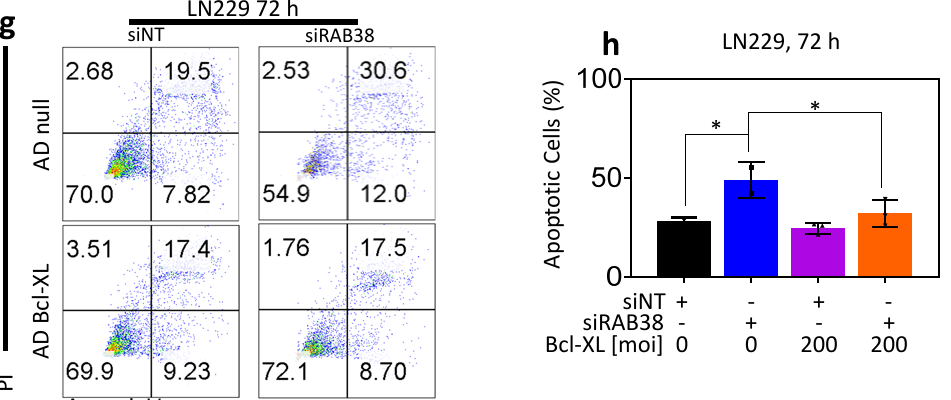
Figure 4. RAB38 silencing downregulates the protein expression of antiapoptotic Bcl-2 family members. ( a – c ) RAB38 knockdown was performed in LN229 ( a ), T98G ( b ), and GBM43 ( c ), and whole-cell protein extracts were examined by Western blot analysis of Mcl-1, Bcl-2, Bcl-xL, and RAB38. β -Actin Western blot analysis was performed to confirm equal protein loading. Protein quantification was analyzed through ImageJ. Representative plots and a histogram with statistical analysis are presented ( n = 3). ( d ) Bcl-xL overexpression was performed in LN229 using an adenovirus, and whole-cell protein extracts were examined by Western blot analysis of Bcl-Xl and β -actin. Bar graphs display protein quantification levels determined by ImageJ. ( e , f ) LN229 cells were transfected with nontargeting (NT) or RAB38-specific siRNA (siRAB38) using either cells overexpressing Bcl-xL or controls. After 72 h ( e ) or 7 days ( f ), cellular viability was determined by CellTiter-Glo assay and relative cell viability was calculated. Data are presented as mean and SD, n = 3. ( g , h ) LN229 glioblastoma cells overexpressing Bcl-xL were transfected with either NT or RAB38 siRNA and stained with annexin V/propidium iodide at 72 h, then analyzed using flow cytometry. Representative plots and a histogram with statistical analysis are presented ( n = 3). * p < 0.05; ** p < 0.01; ***/**** p < 0.001, n.s. means not significant.